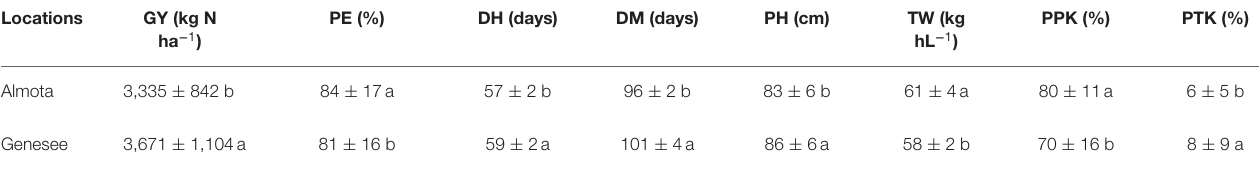
TABLE 7 | Location differences in yield and grain quality across all N treatments, varieties, and years.